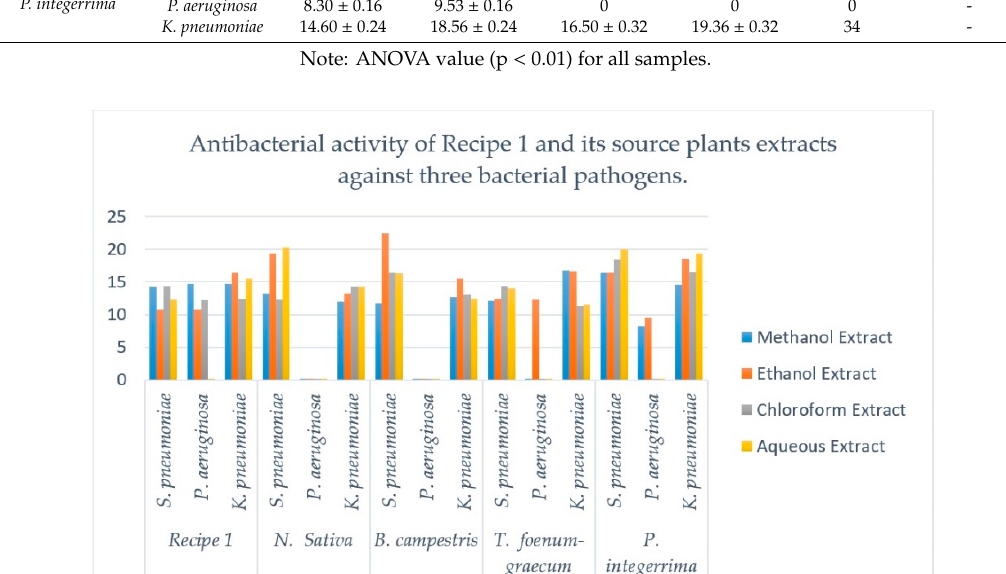
Figure 2. Comparative antibacterial activities of methanol, ethanol, chloroform and aqueous extracts of the N. sativa (seeds), B. campestris (seeds), T. foenum-graecum (seeds) and P. integerrima (galls) in Recipe 1. Each column represents the mean value of three independent replicates and the error bars indicate standard deviation.